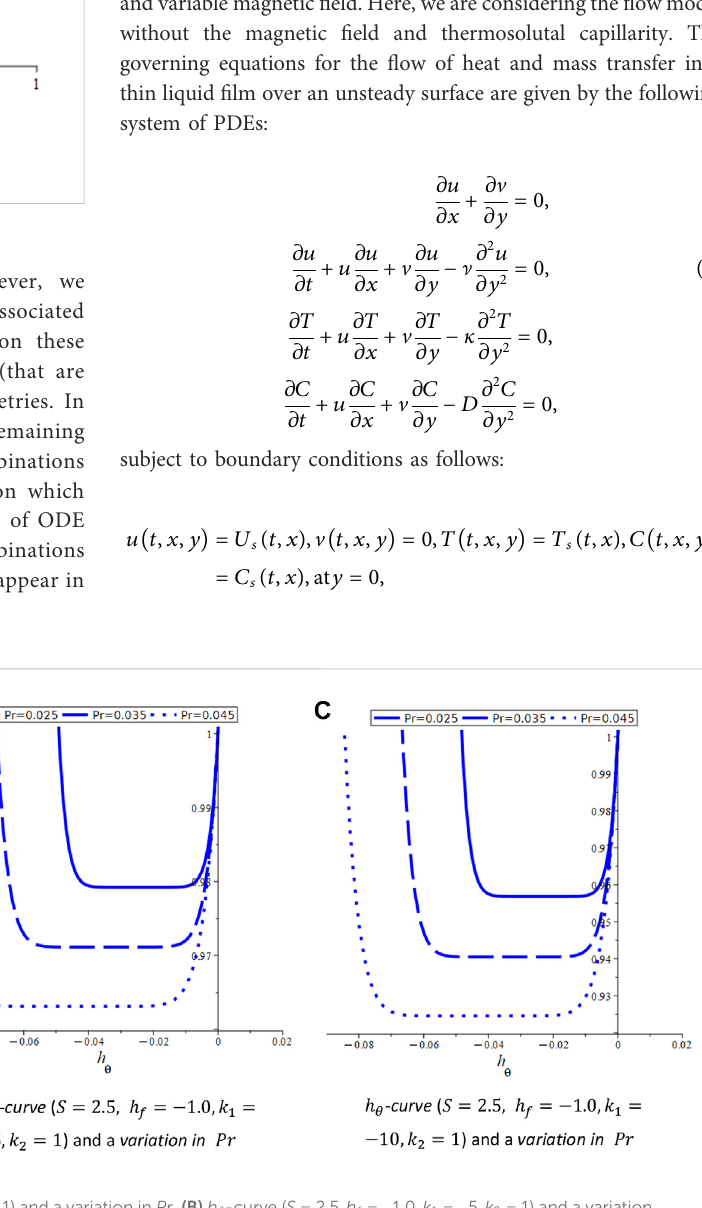
Different h-curves. (A) h θ -curve ( S (cid:1) 2 . 5 , h f (cid:1) − 1 . 0 , k 1 (cid:1) − 1 , k 2 (cid:1) 1) and a variation in Pr . (B) h θ -curve ( S (cid:1) 2 . 5 , h f (cid:1) − 1 . 0 , k 1 (cid:1) − 5 , k 2 (cid:1) 1) and a variation in Pr . (C) h θ -curve ( S (cid:1) 2 . 5 , h f (cid:1) − 1 . 0 , k 1 (cid:1) − 10 , k 2 (cid:1) 1) and a variation in Pr